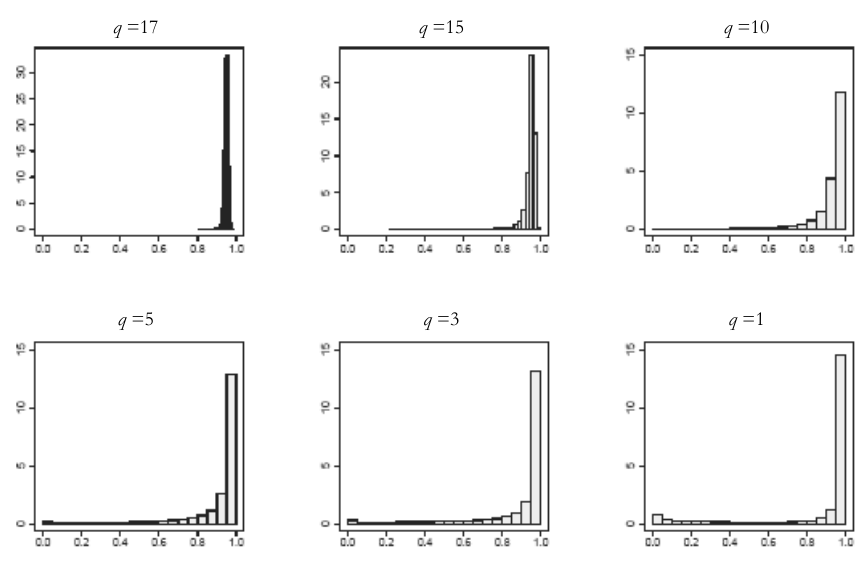
Figure 6 – qp -hist plots for G 1 = ( V , E 1 ) with n